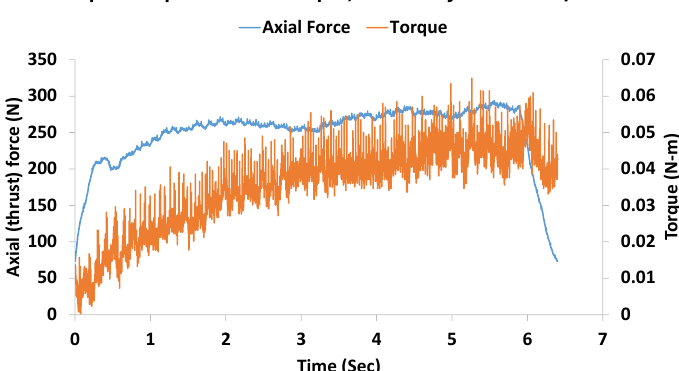
Figure 2. Representative dynamic axial force and torque measurement in drilling of a hole at spindle speed N = 2000 × rpm and feedrate f = 0.08 mm/rev.